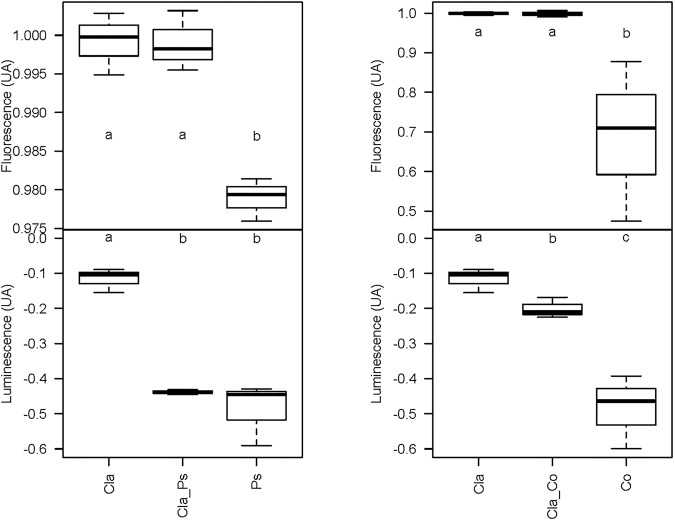
Box plot representing the variation of the luminescence and viability (fluorescence) of the biosensor V. campbellii MM32 by the bacterial or the fungal monoculture and the co-culture. Cla, Cladosporium monocultures; Cla_Co, Cladosporium-Cobetia co-cultures; Co, Cobetia monocultures; Cla_Ps, Cladosporium-Pseudoalteromonas co-cultures; Ps, Pseudoalteromonas monocultures. Error bars represent standard deviation for three replicates. Different letters indicate statistically significant differences between groups [mean ± SEM, N = 3, Van Der Waerden test followed by a post hoc test using the Fischer’s least significant difference (LSD), p < 0.05].